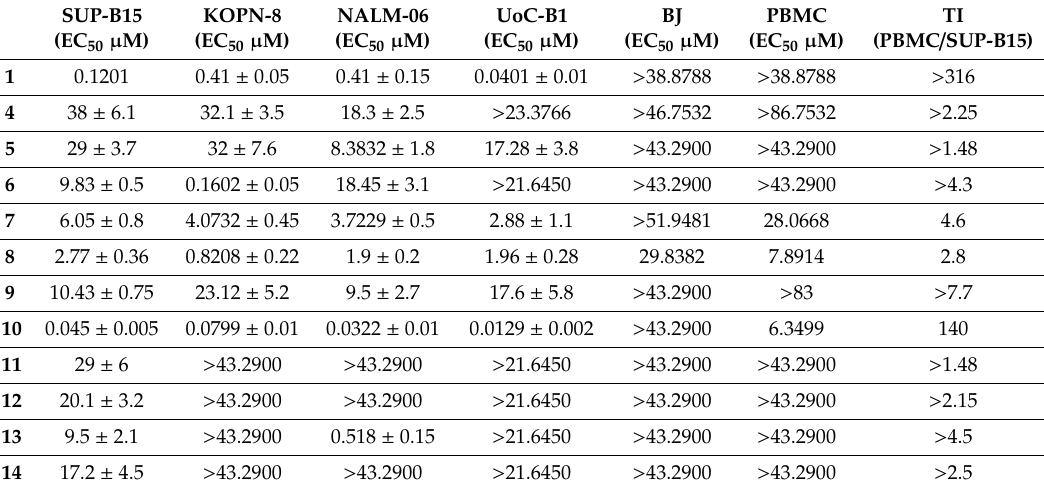
1 Table represents mean ± SEM of triplicates. Analysis via Pipeline pilot or GraphPad Prism